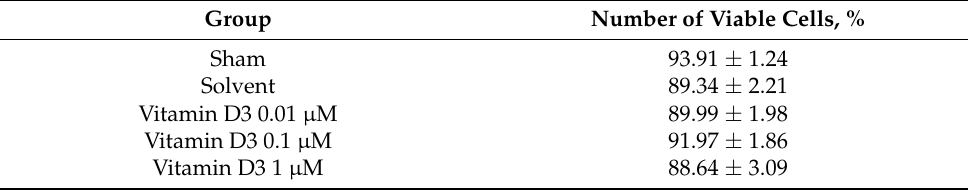
Table 1. Cell viability of primary neuronal cultures on day 7 after vitamin D3 application.